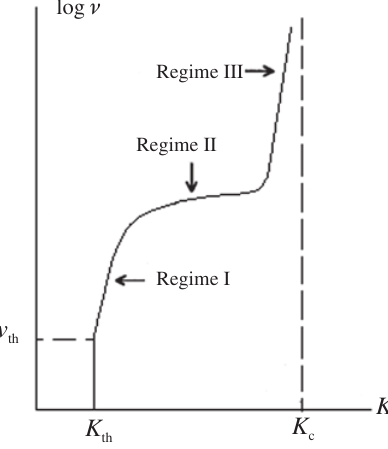
Figure 1: The dependence of crack propagation speed on stress intensity factor.